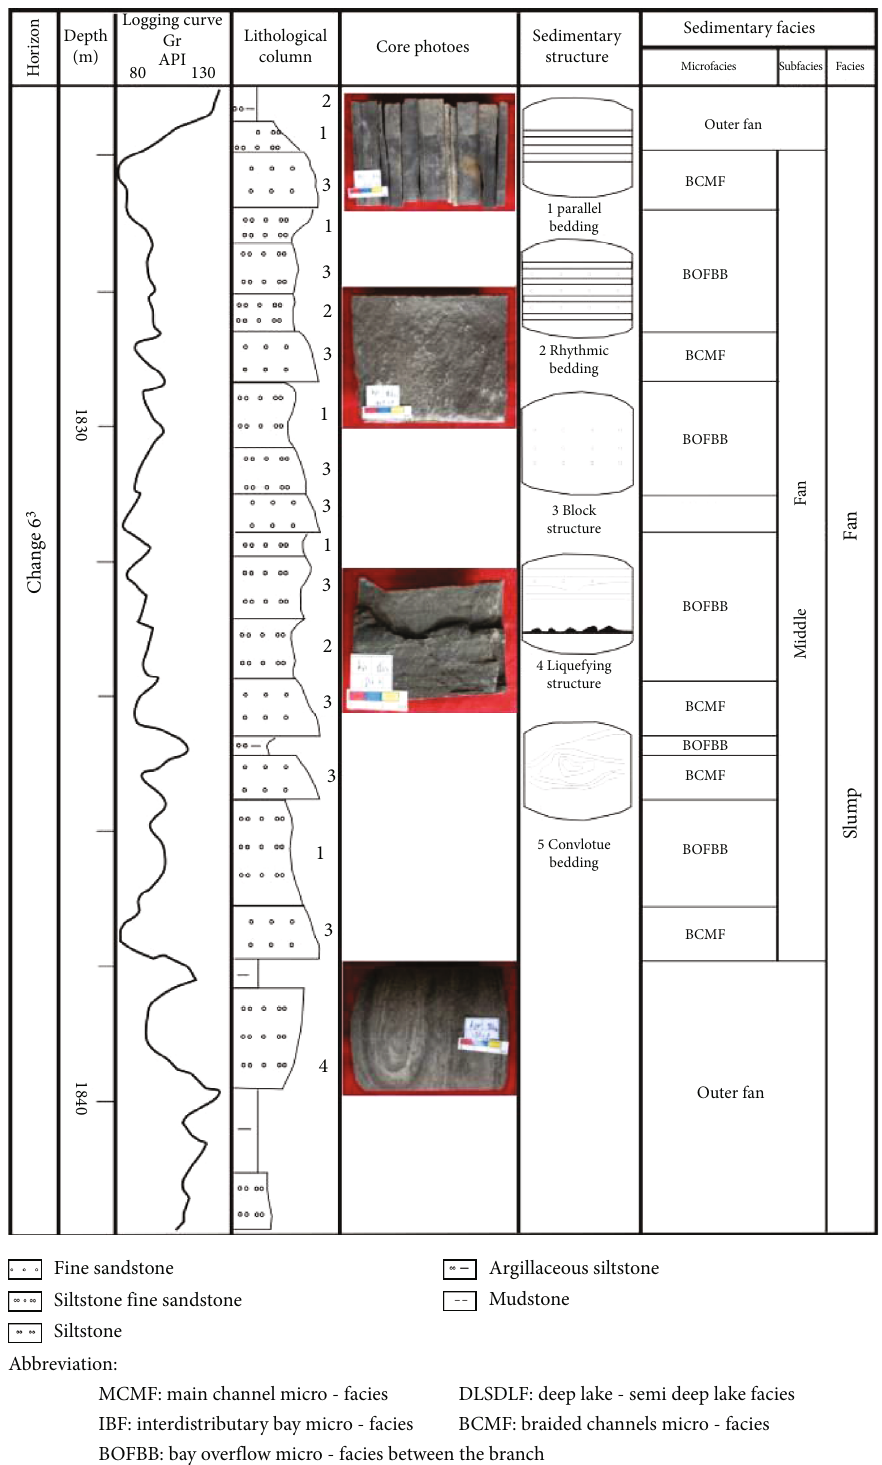
Figure 5: Slump fan facies of the Chang 6 3 Member, Wu62